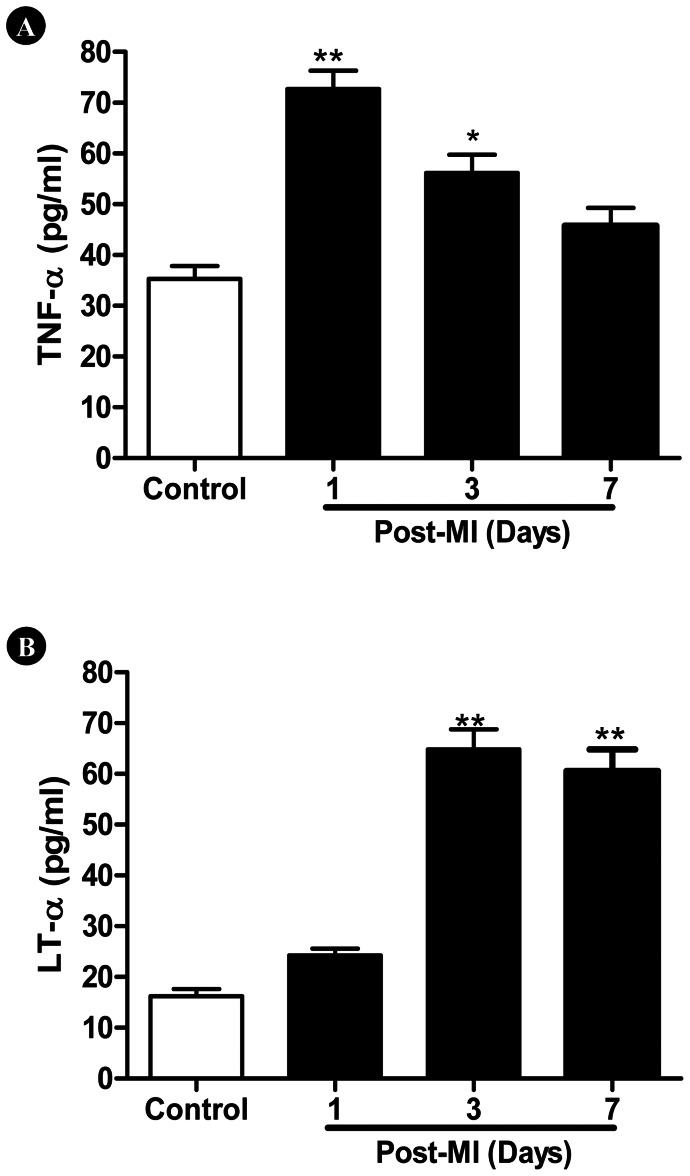
Time course of post-MI (A) TNFα and (B) LTα production.N = 14–16/group. *P<0.05, **P<0.01 vs. control.